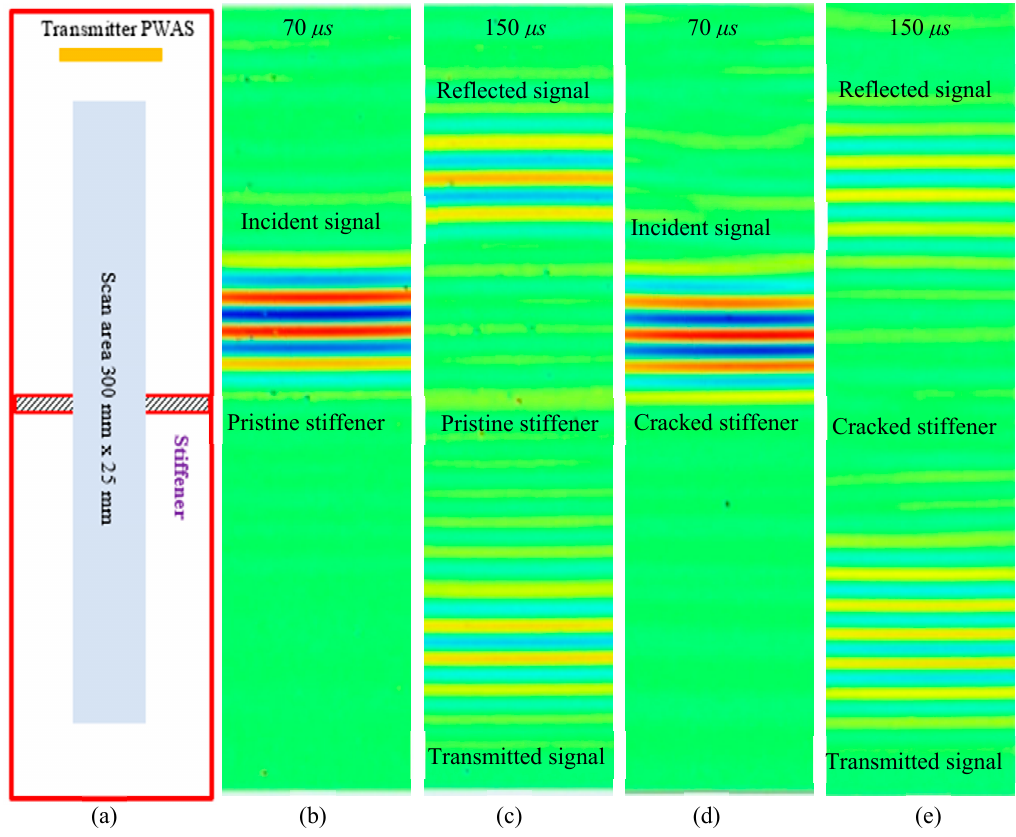
Figure 9. Experimentally measured scattered wavefields using SLDV: ( a ) scan schematic; ( b ) incident wave and ( c ) reflected and transmitted waves from pristine stiffener; ( d ) incident wave, and ( e ) reflected and transmitted waves from the cracked stiffener.